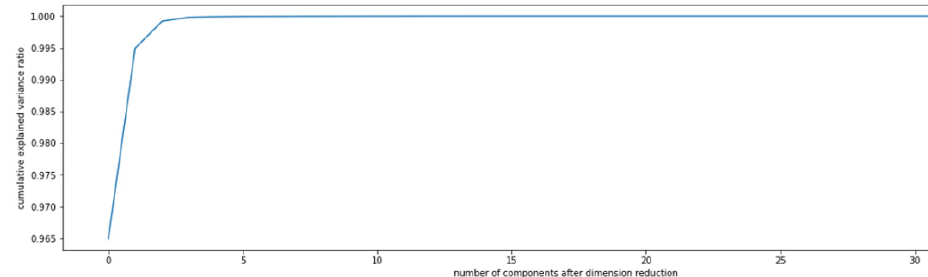
Figure 12. The proportion of dimensions and information.